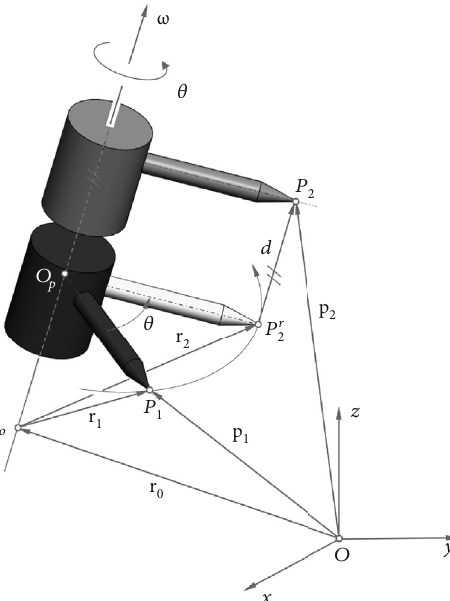
Figure 2: Geometry of general spatial displacement of a rigid